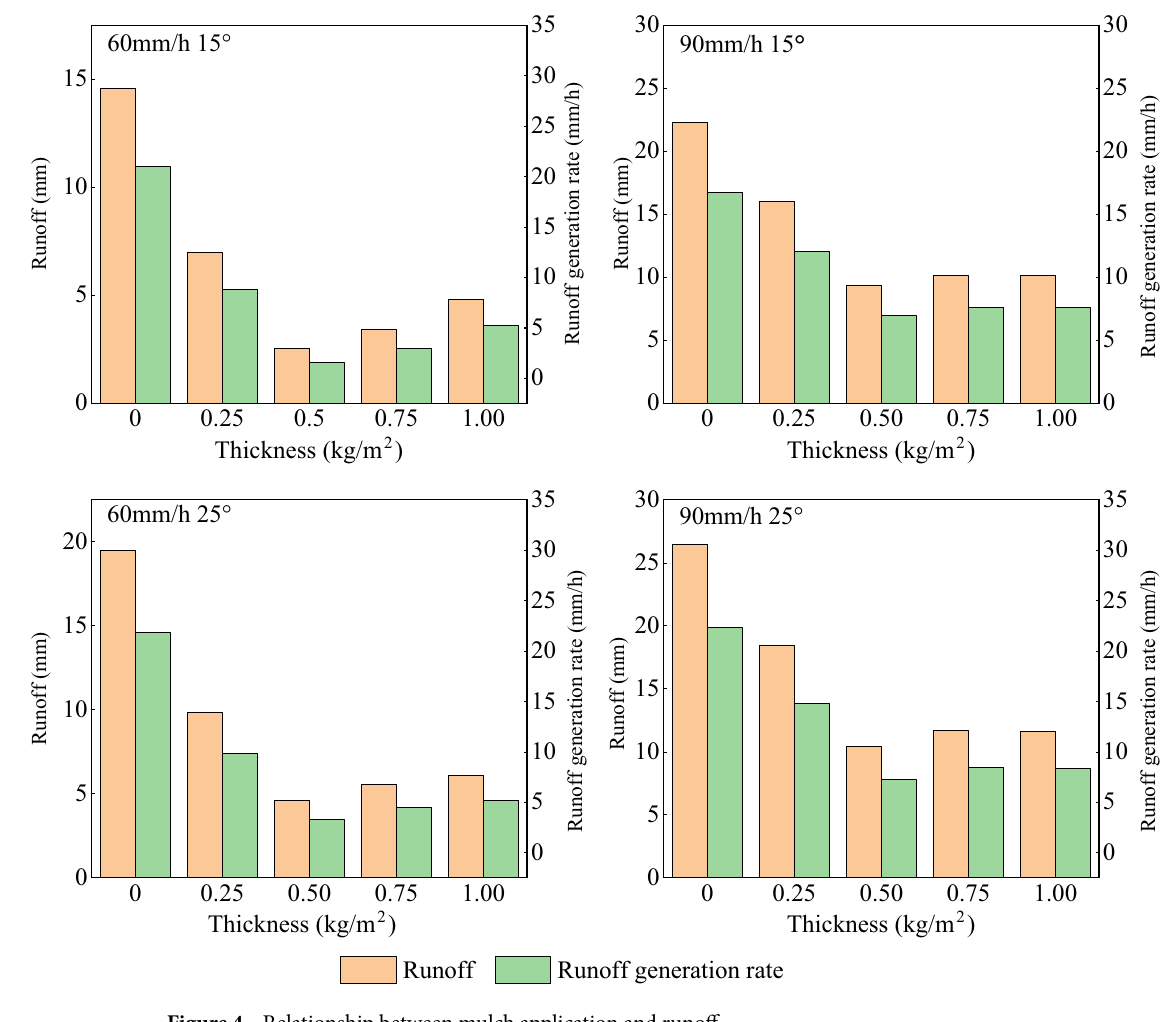
Figure 4. Relationship between mulch application and